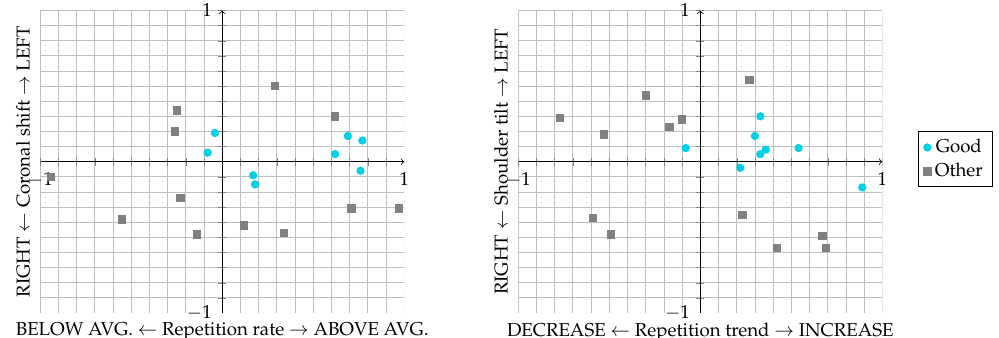
Figure 8. Plot of Repetition rate–Coronal shift and Repetition trend–Shoulder tilt features in the EquilibriumPaint game. Data were labelled as “Good” or “Other” by the therapist according to patients’ performance.